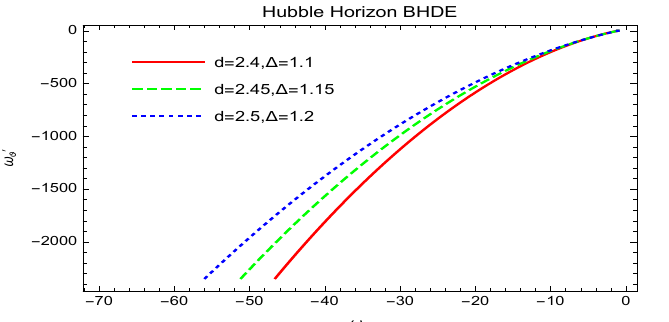
Figure 9. The behavior of ω ϑ versus ω (cid:48) context of GDP braneworld